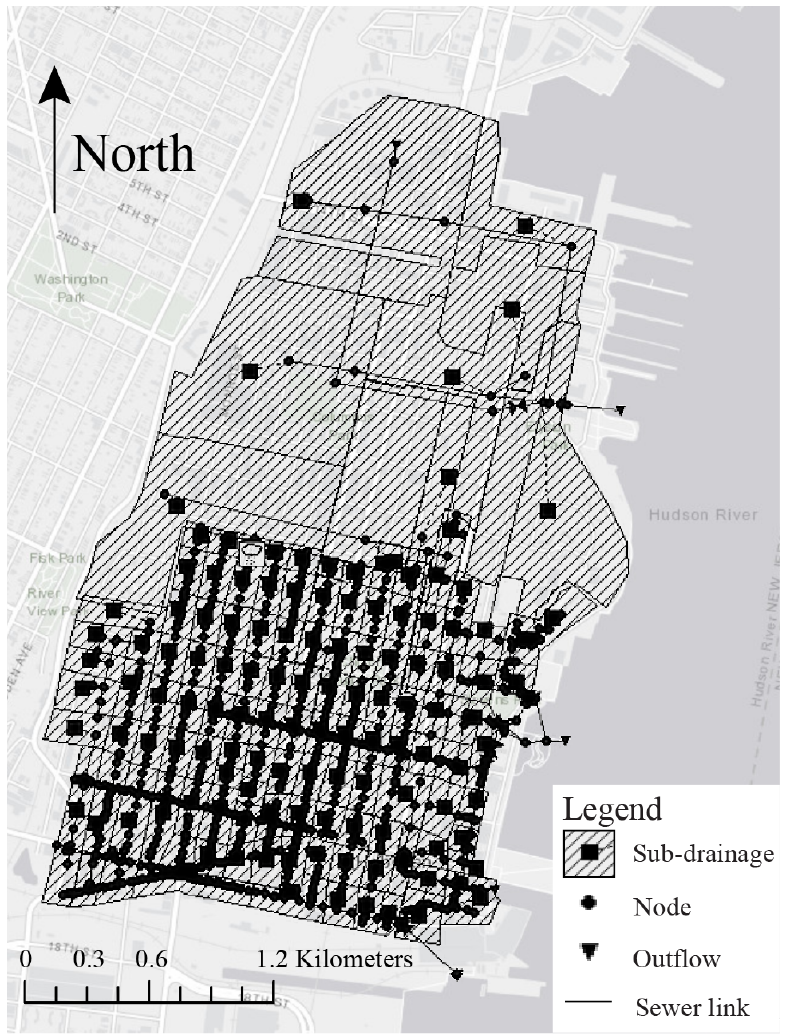
Figure 4. Sewer network of the City of Hoboken as implemented in SWMM